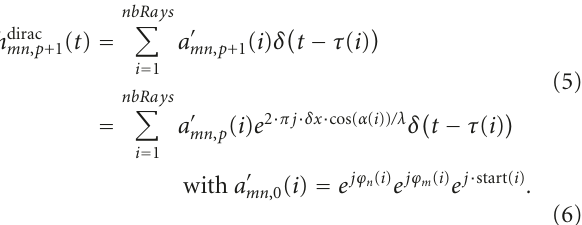
Figure 2: Example of MIMO configuration.